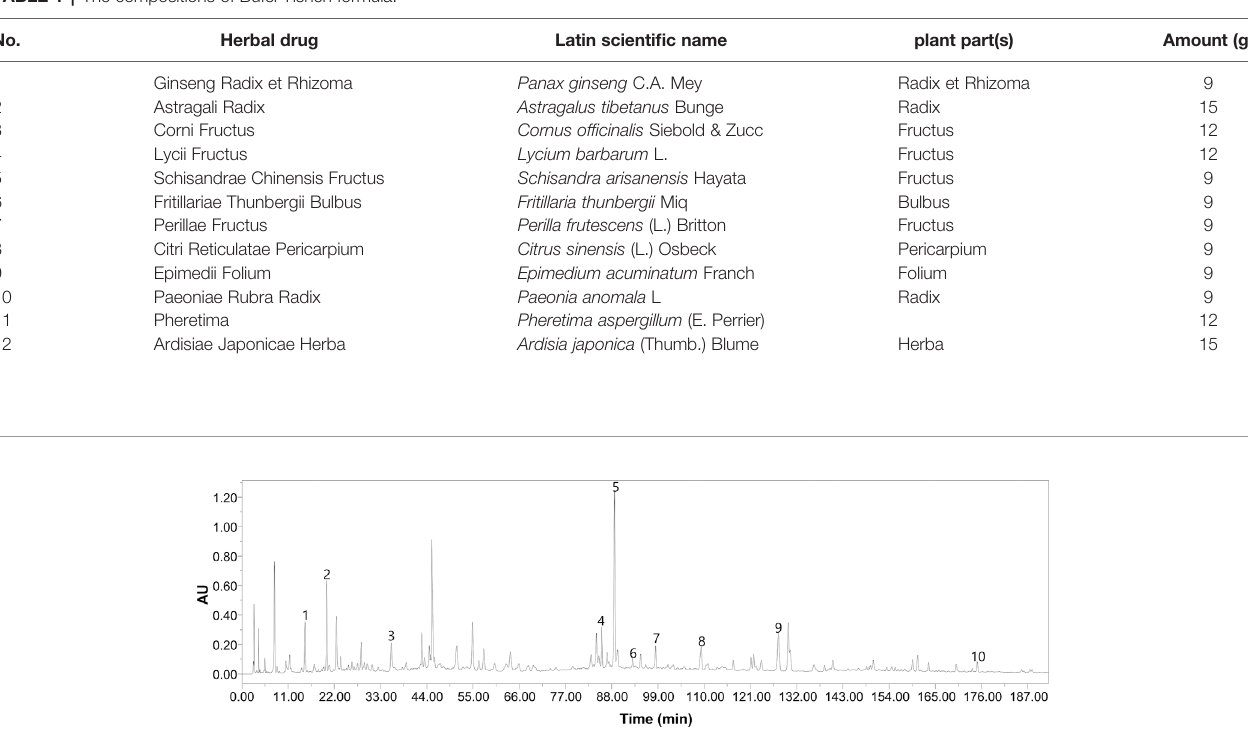
FIGURE 1 | The high-performance liquid chromatography (HPLC) – UV chromatogram of Bufei Yishen Formula (BYF). Peak number and identity, 1: ursolic acid (PubChem CID: 64945); 2: bergenin (PubChem CID: 66065); 3: paeoni fl orin (PubChem CID: 442534); 4: Epimedin C (PubChem CID:5748394); 5: icariin